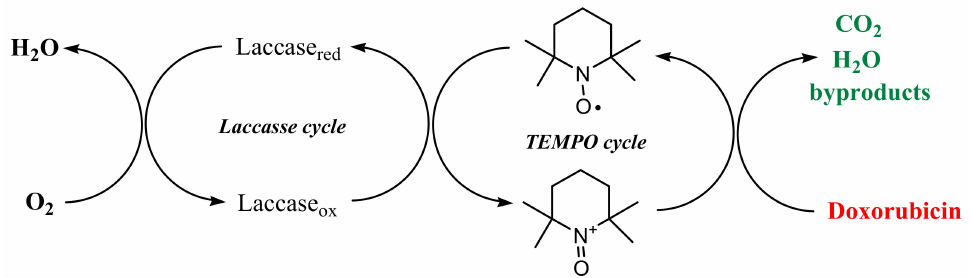
Figure 2. An overview of the laccase enzymatic process and of the TEMPO mediator in aerobic degradation of